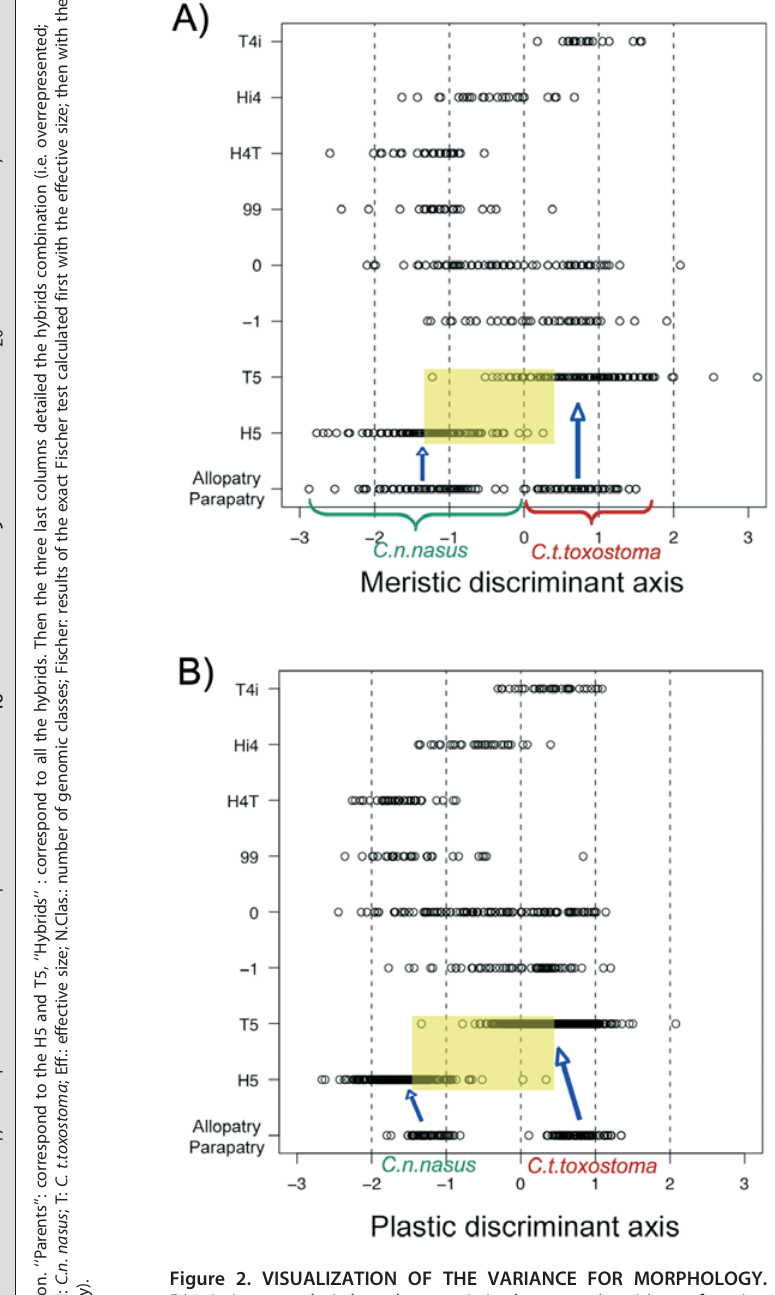
Figure 2. VISUALIZATION OF THE VARIANCE FOR MORPHOLOGY. Discriminant analysis based on meristic characters (x-axis) as a function of genetic class (y-axis). -1=underrepresented combinations; 0=com- binations present in the expected proportions; 99=overrepresented combinations other than T5, H5,T4i, Hi4 and H4T, which are represented separately (see the text for more detail). A) Meristic data set; B) Plastic data set on the global data set.